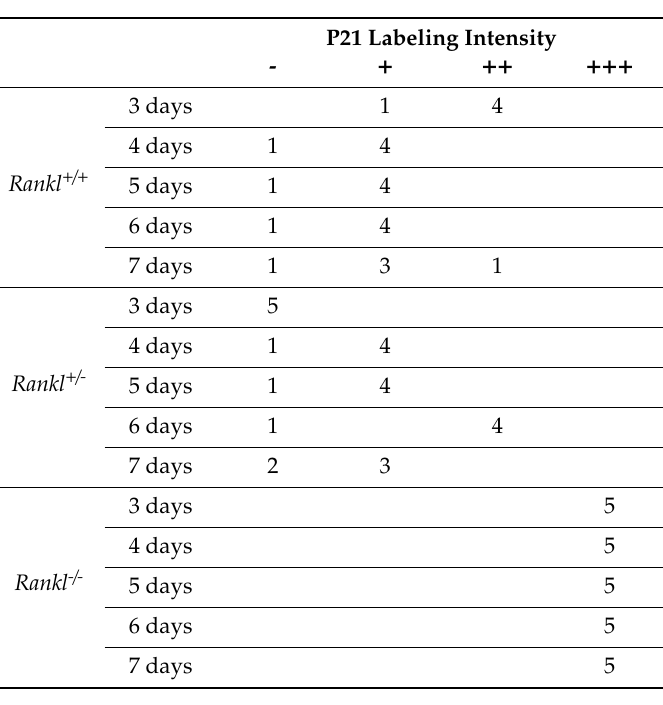
Table 3. Evaluation of P21 labeling intensity in the apical area of the mandible first molar root according to genotype and age. Quantification was made on sections of five di ff erent mice for each group (genotype) and each age (all from postnatal days 3 to 7). -: no detection; + : low staining intensity; ++ : intermediate staining intensity; +++ : high staining